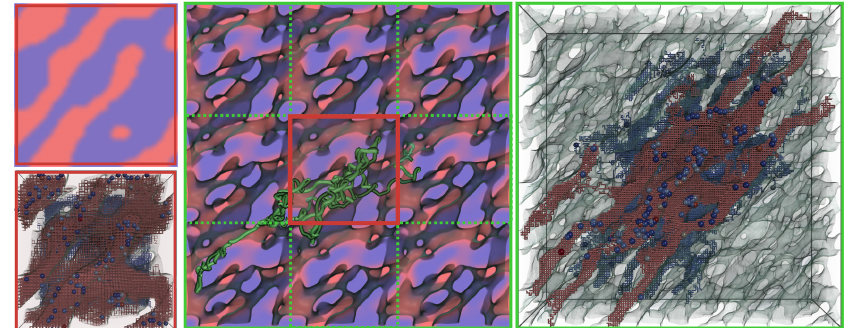
Figure 5. The simulation uses periodic boundary conditions, meaning that charges leaving the volume on one side will enter it again on the opposite side. Thus the trajectories are disrupted and the resulting density distribution misleading. The system supports a periodic continuation of the volume to get an untangled representation. The image on the left (bottom) represents raw data in the original simulation volume in contrast to the same data in the extended volume shown on the right. The image on the top left shows a slice through the morphology. The image in the center results from a periodic continuation of the morphology with one selected flow line. The original volume is highlighted by a red